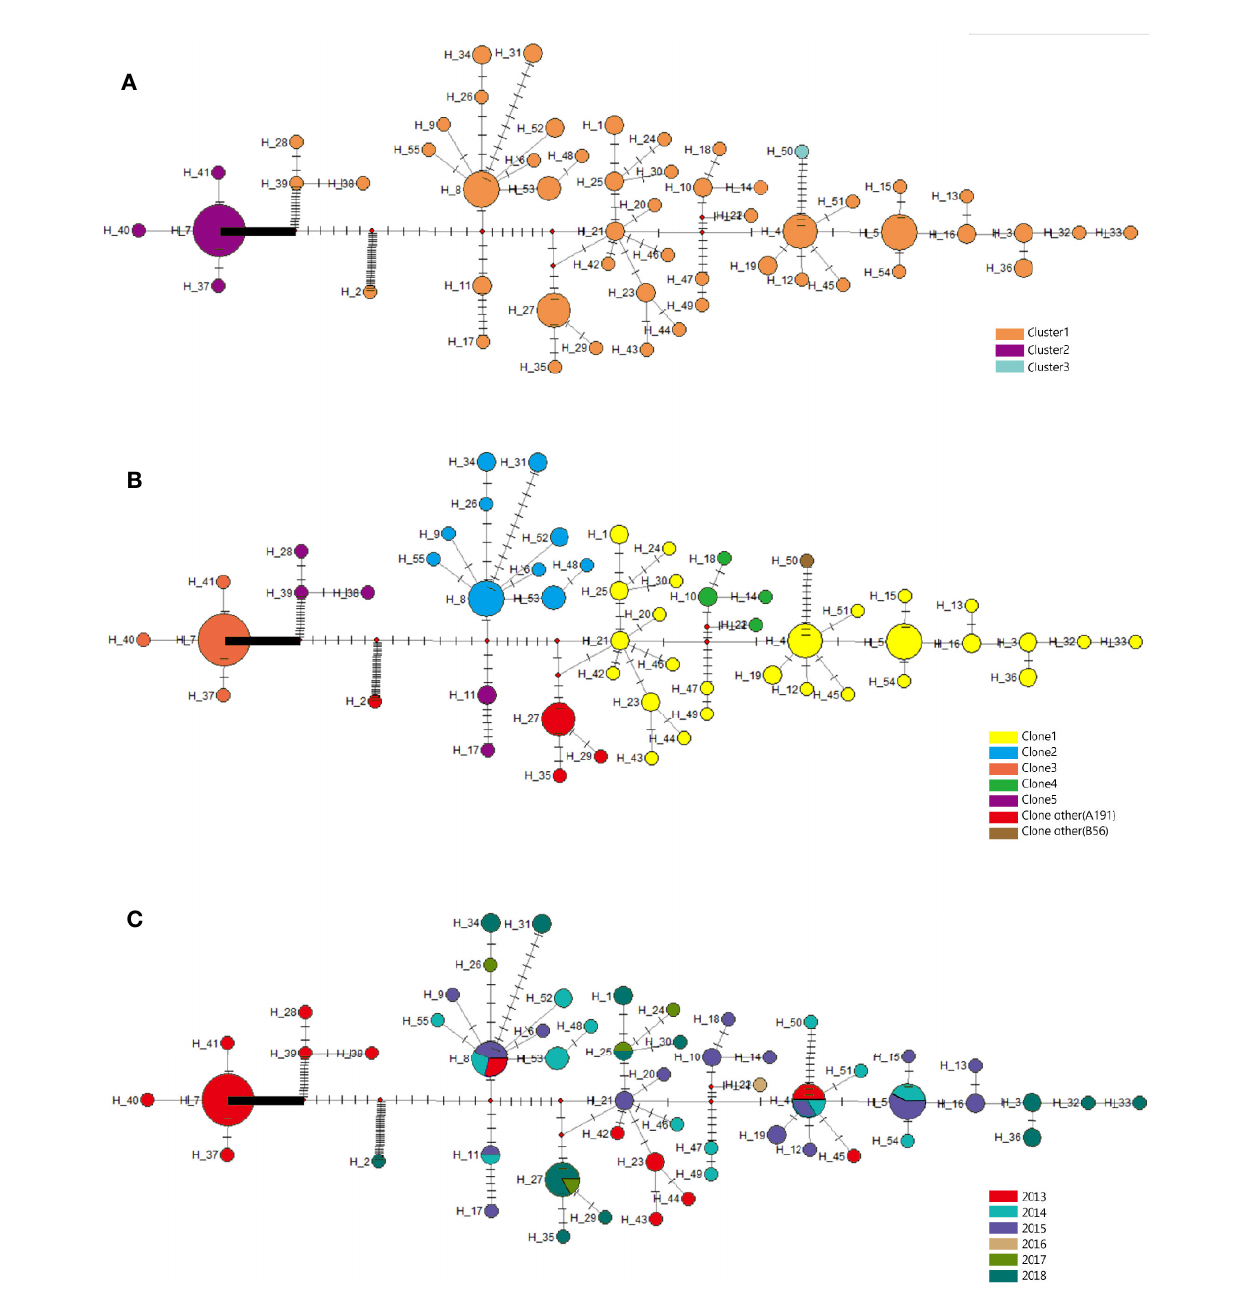
FIGURE 6 | Evolutionary relationships and geographical distribution of 55 haplotypes of 105 isolates from Shunde hospital. (A) Circle colors represent different clusters based on bayesian classi fi cation. (B) Circle colors represent different clonalities based on SNP distance. (C) Circle colors represent sampling time. The density of those bars represents the genetic distance between the haplotypes; circle sizes represent the number of isolates in a